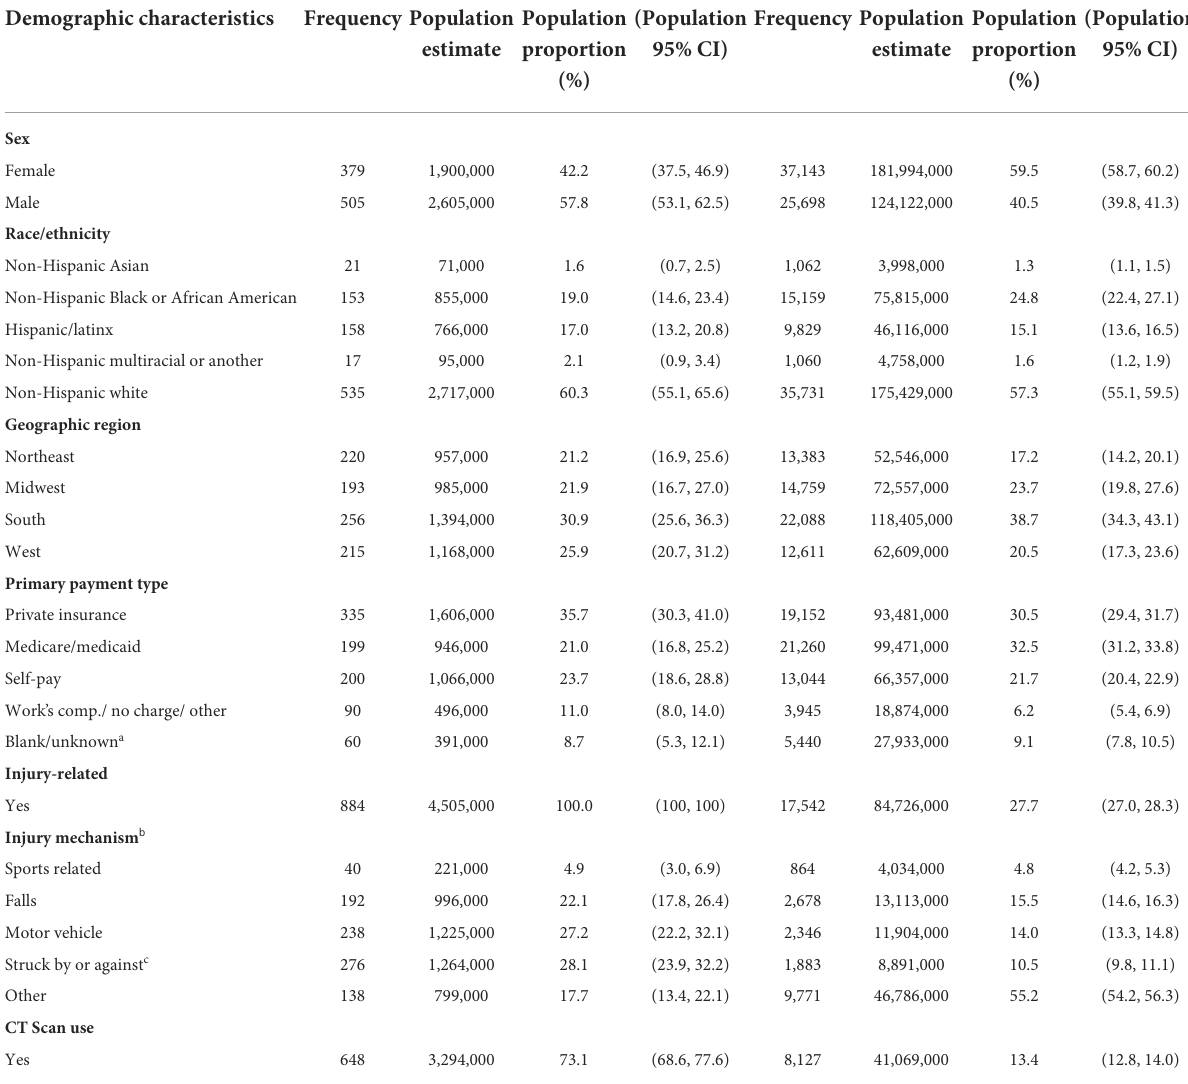
TABLE 1 Descriptive characteristics of adult emergency department visits by concussion and no-concussion diagnosis ( n = 63,725; est =